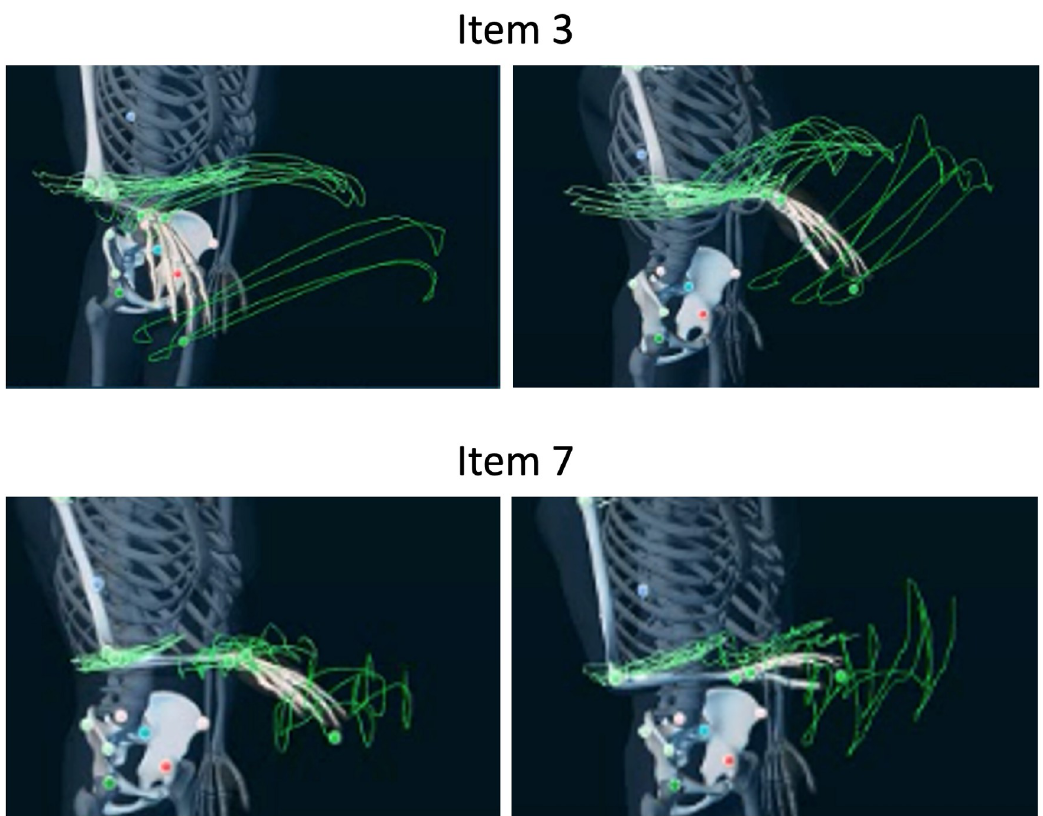
Fig 3. Movement trajectory of upper limb activity during item 3 and item 7 of STEF used by MyoMotion. The left side of the image is the slow condition, and the right side is the fast condition. The green lines in the images show the movement trajectory of the upper